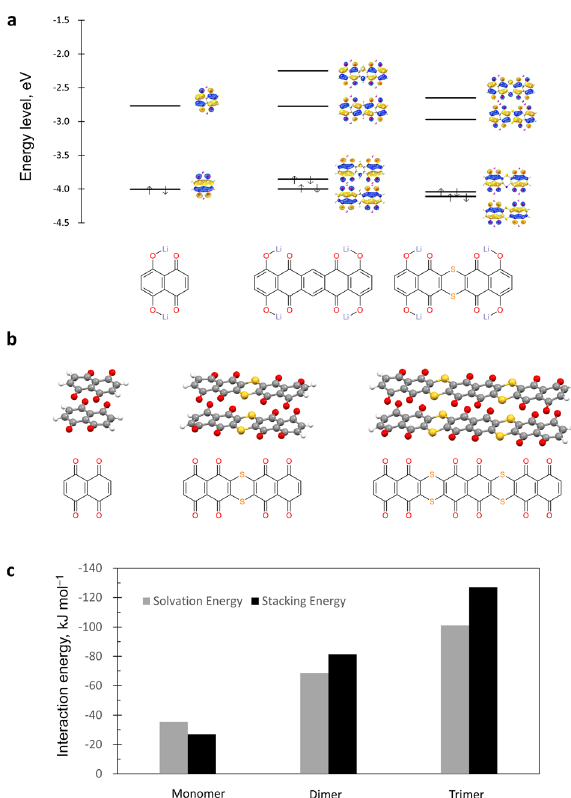
Fig. 8 Quantum chemistry calculation for naphthazarin derivatives. a The calculated energy level diagrams of some MOs of the lithium salt of the naphthazarin-monomer ( 1 ), a benzo-fused dimer ( 2 ′ ), and the dithiin-fused dimer ( 2 ). b The calculated stacking structures of the fully charged states of 1 , 2 , and a hypothetical trimer 3 . c Comparison of stacking energy and solvation energy calculated for the fully charged state of 1 , 2 , and 3